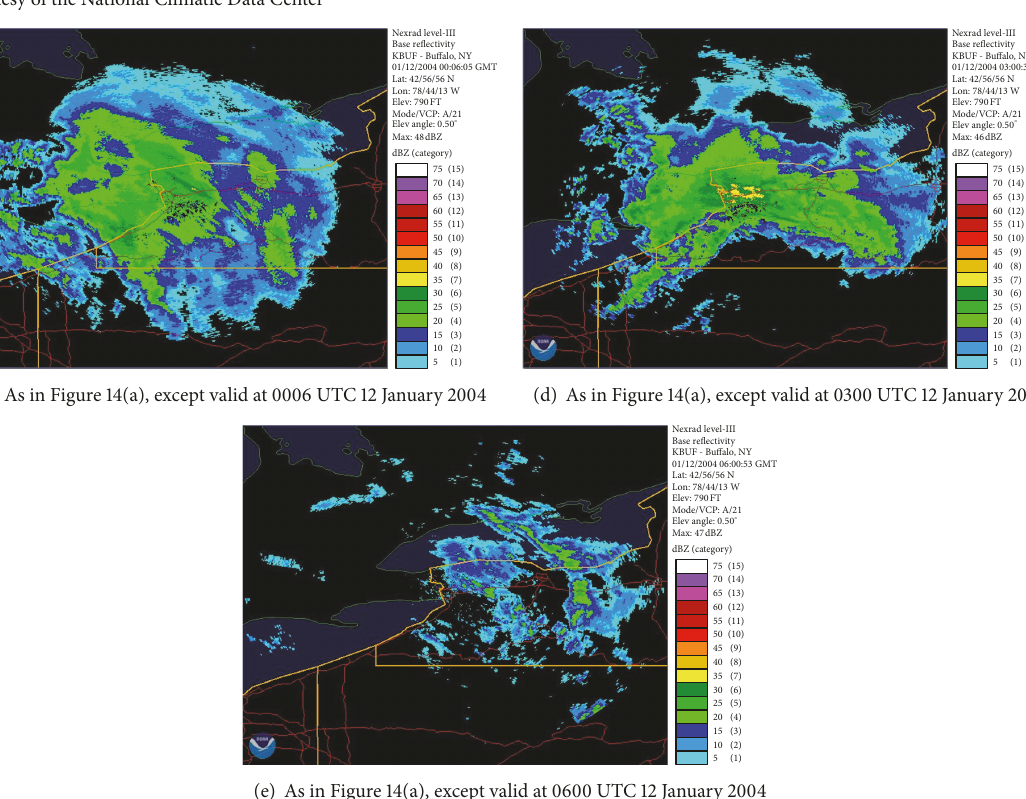
elevation radar reflectivity (dBZ), valid at 1758 UTC 11 January 2004, courtesy of the National Climatic Data